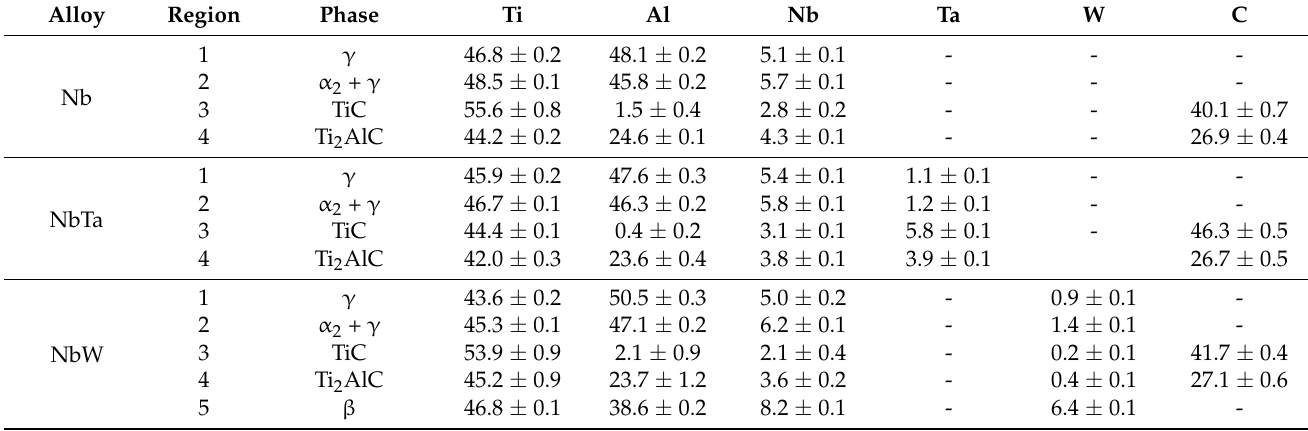
Table 2. Chemical composition of coexisting phases of the studied alloys (at.%).